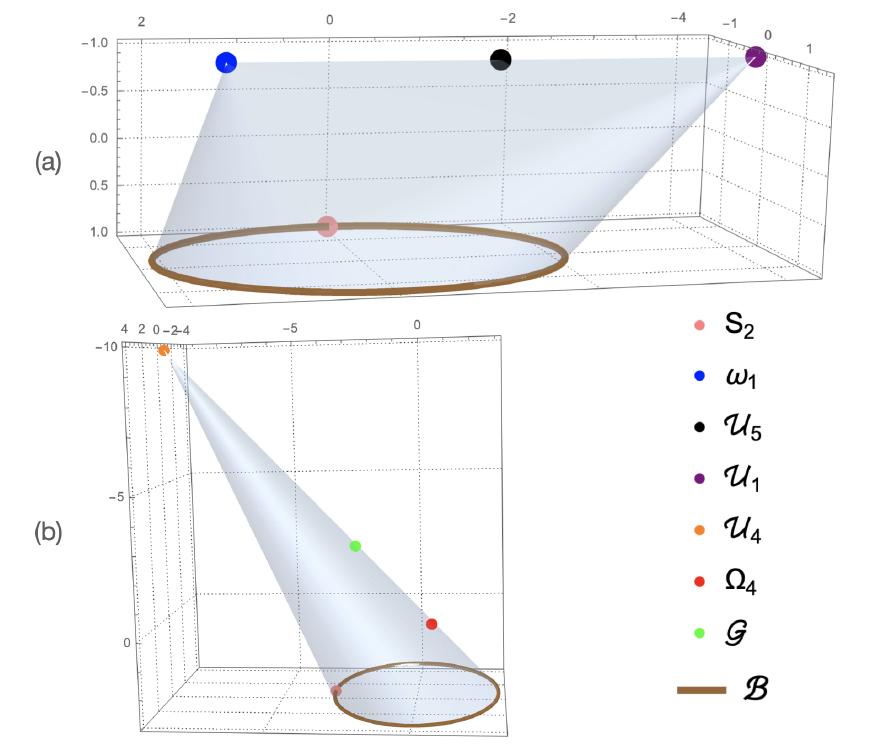
Figure 8 . Two 3D cross-sections for the 5D positivity bound cone (described by (7.10)) in eu scattering. In Subfigure (a), the ( x, y, z ) coordinate values correspond to ( C 2 , − 2 C 1 − 3 C 3 + C 4 +2 C 5 , C 5 − C 1 √ ) , while in Subfigure (b), the ( x, y, z ) values correspond to √ 3 2 2 ( C 2 , 2 C 1 + C 4 +2 C 5 , C 5 − C 1 √ ) 3 2